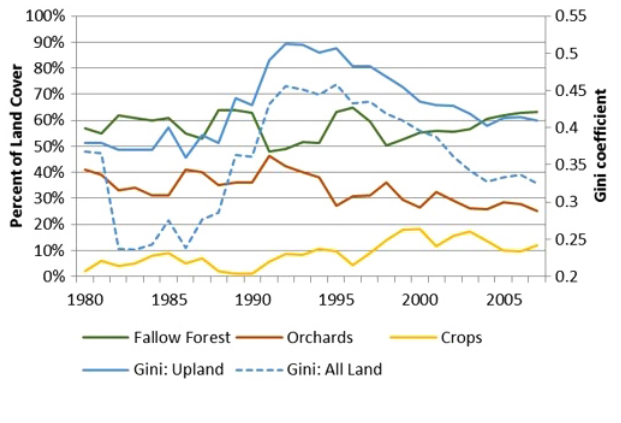
Fig. 3 . Land size inequality and upland land cover change, San Jose, 1980-2007.